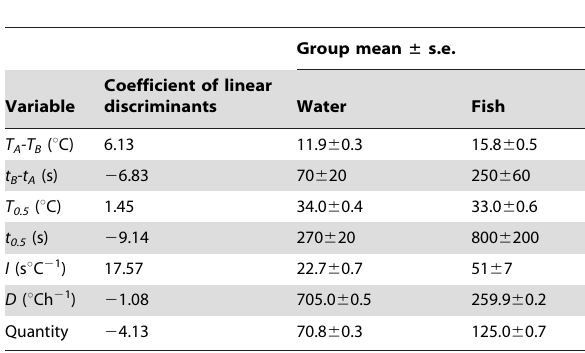
Table 4. Summary of the linear discriminant analysis on 7 stomach temperature variables from water and fish ingestions ( n =11) in a simulated harbour seal pups